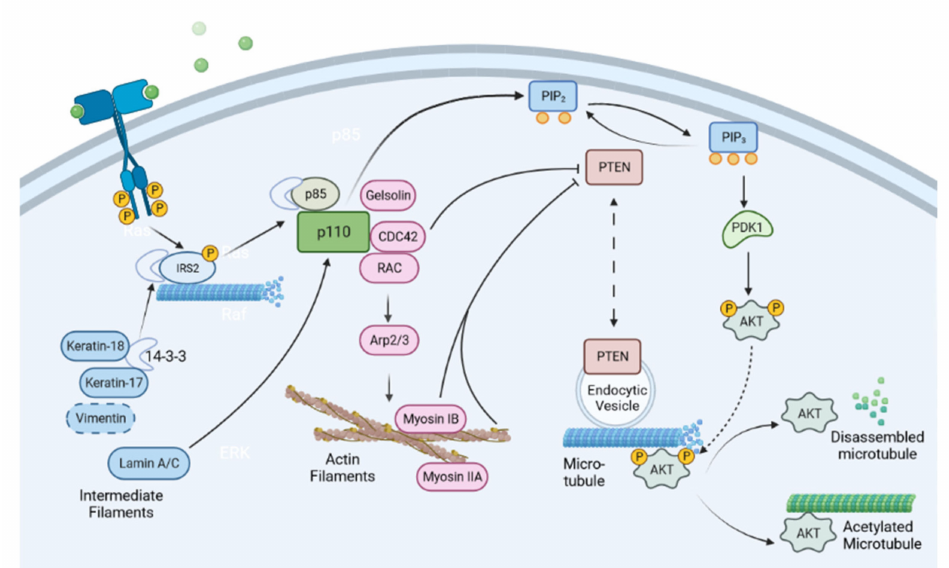
Figure 4. Cytoskeletal elements regulate PI3K/AKT signaling cascade. The three types of cytoskeleton collectively control the PI3K/AKT pathway. The cytoskeleton and its associated proteins play critical roles in regulating multiple steps and players of the PI3K/AKT signaling pathway, including signaling molecule recruitment, antagonist sequestration, and regulation of gene expression. Image created with BioRender.com (accessed on 14 February